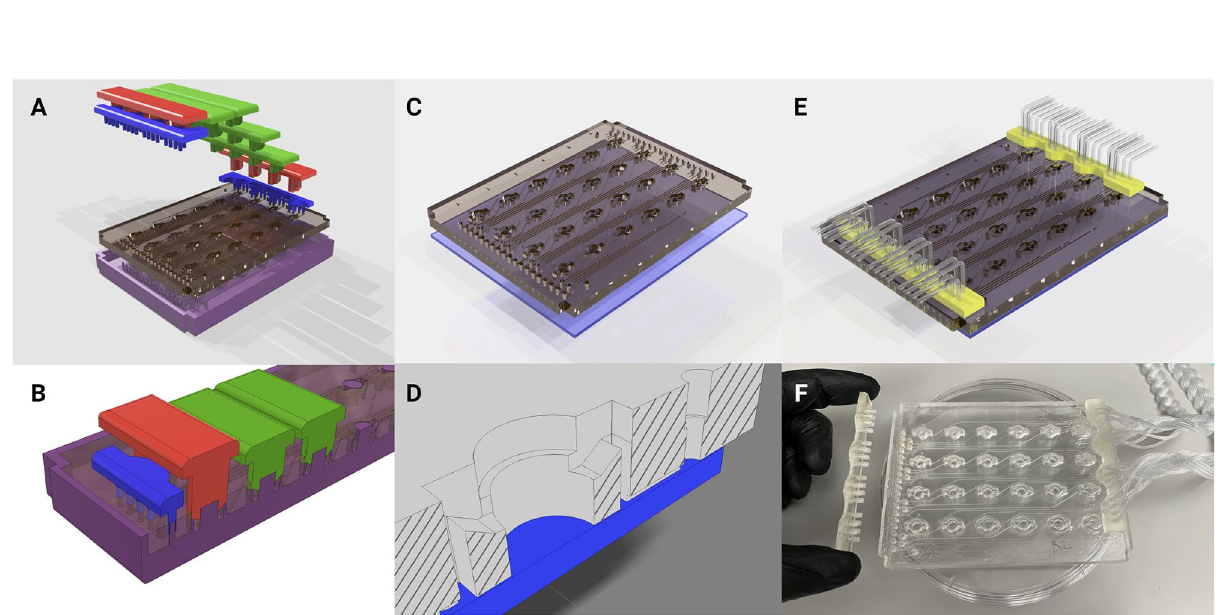
Figure 4. Fabrication of the PDMS microfluidic chip. ( A ) Graphical rendering of the interlocking mold pattern for the PDMS substrate in the microfluidic chip assembly. ( B ) Interlocking mounts (blue, red, and green) affix to the base mold (purple) and define microfluidic geometries upon the poured PDMS that are retained as the substrate cures. ( C ) The PDMS substrate is removed from the mold and bonded to glass. ( D ) A cross-sectional rendering of the chip. Fluid enters from microfluidic inlets on the surface and follows channels sealed by glass on the bottom to wells with open access from the top. ( E ) A 3D-printed fluidic interface plate (yellow) connects 24 fluidic microtube lines with the inlets/outlets of the microfluidic chip. ( F ) Microfluidic chip (center) with an example of the fluidic interface plate (left) and fully installed fluidic interface plate